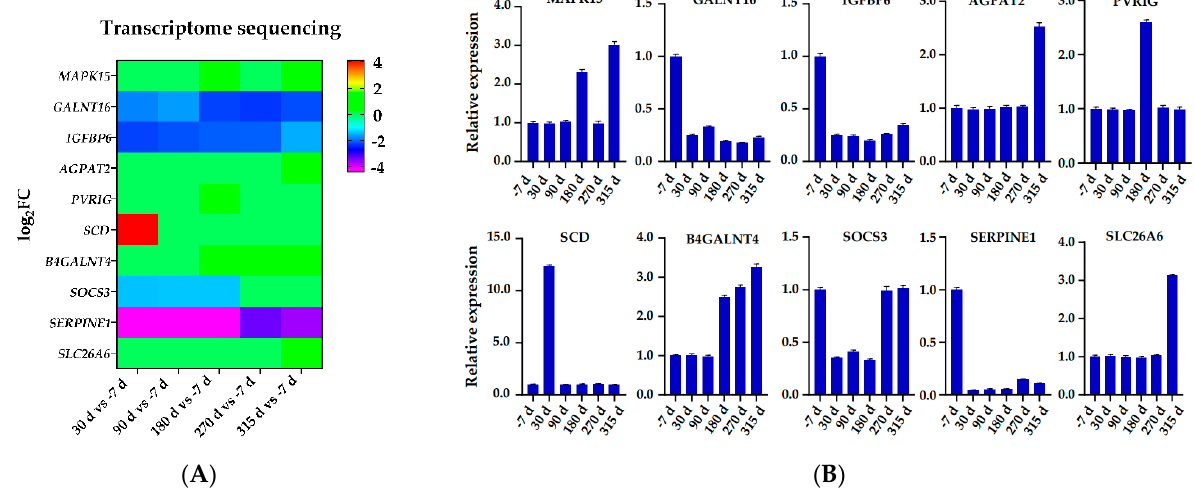
Figure 3. Verification transcriptome sequencing data using qRT-PCR. ( A ) Transcriptome sequencing data based log2-fold change expression. ( B ) qRT-PCR-based relative expression profiles.